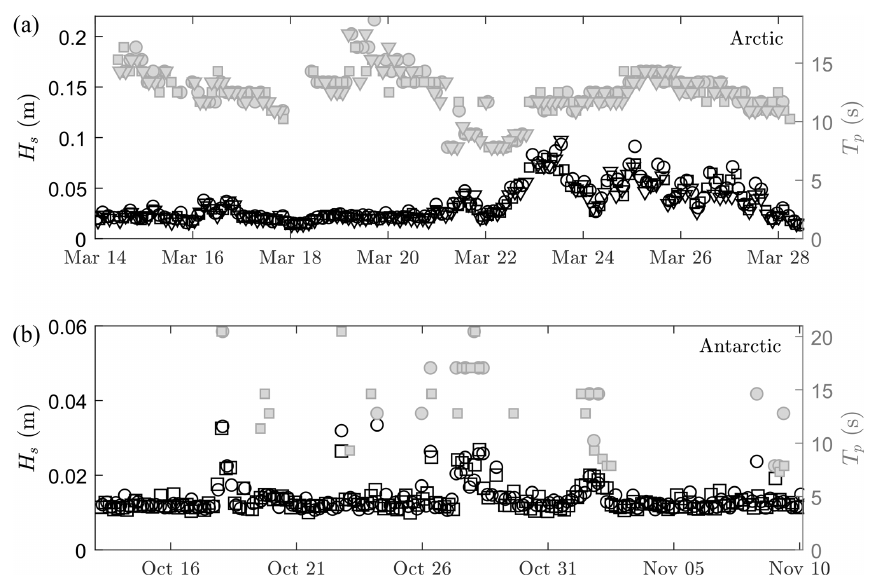
Figure A1. Measured wave height (black) and peak period (gray) during (a) the Arctic experiment (taken from Voermans et al., 2020) and (b) the Antarctic experiment. Note that the noise threshold of H s is approximately 1.5cm. Squares, circles, and inverted triangles relate to different instruments within each experiment.